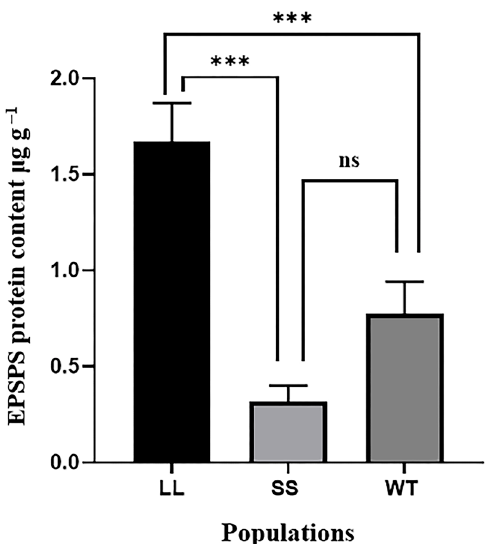
Figure 4. EPSPS protein content in leaf tissues of three goosegrass populations using enzyme-linked immunosorbent assay. Ten individuals were selected from each population. Vertical bars show the standard error of the mean for the replicates. Asterisks indicate significant differences in protein content when analyzed using the non-parametric Kruskal–Wallis H test ( p < 0.05) and ns indicates no significant differences.